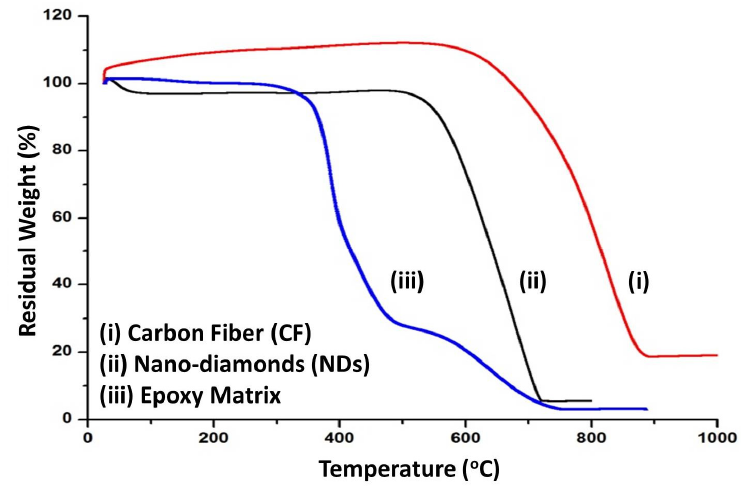
Figure 7. TGA curves depicting the thermal decomposition of epoxy, NDs, and CFs at different temperatures.